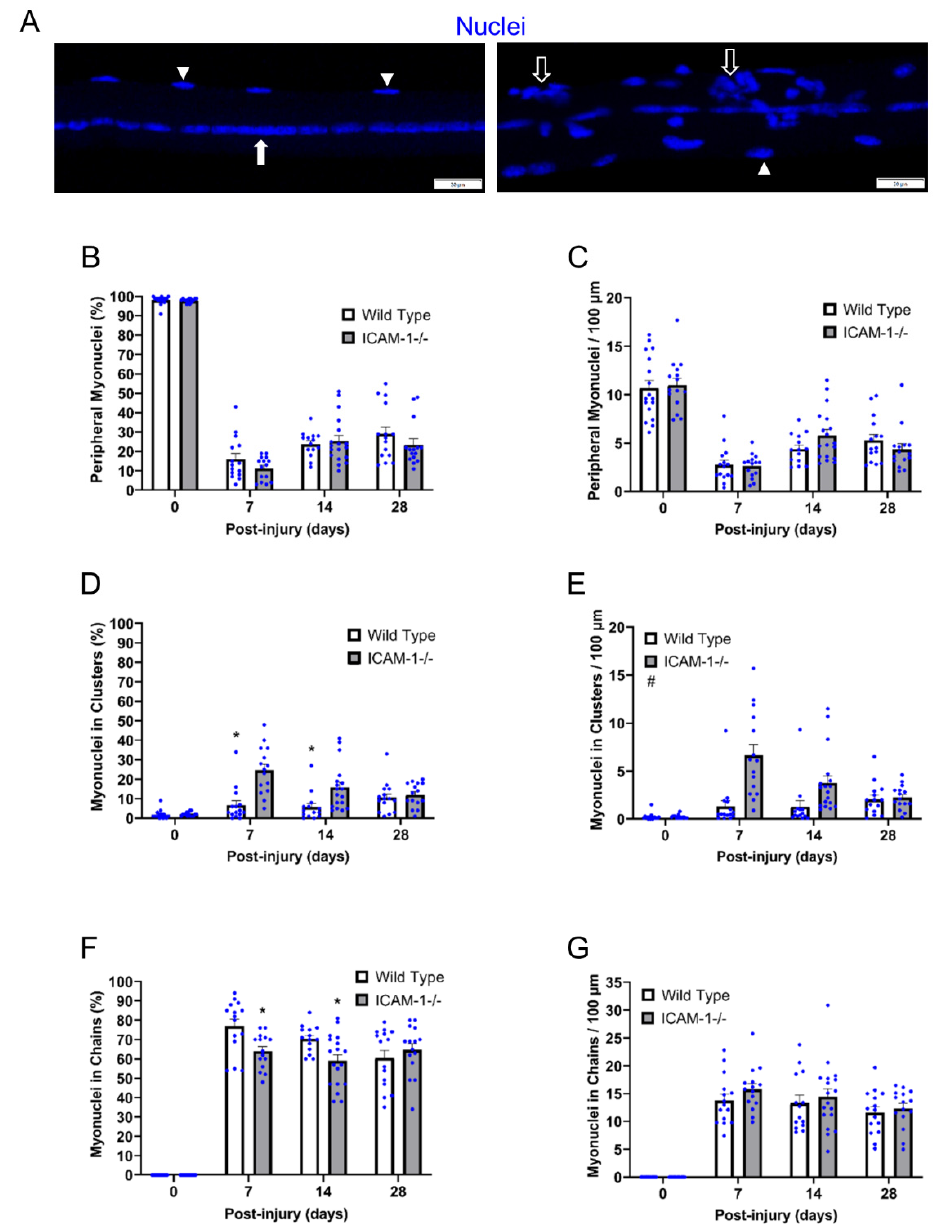
Figure 2. Myonuclear positioning before and during injury-induced muscle regeneration. ( A ) z-projection images of myonuclei (blue) positioned in chains (filled arrow), clusters (open arrow), and a peripheral position (arrowhead) during regeneration. Scale bar = 20 µ m. ( B ) The number of peripheral myonuclei expressed as a percentage of the total number of myonuclei within a myofiber and ( C ) relative to 100 μ m of myofiber length. ( D ) The number of myonuclei in chains expressed as a percentage of the total number of myonuclei within a myofiber and ( E ) relative to 100 μ m of myofiber length. * = lower for Wild Type compared with ICAM-1-/- mice at indicated time point (interaction effect; p = 0.014. ( F ) The number of myonuclei in clusters expressed as a percentage of the total number of myonuclei within a myofiber and ( G ) relative to 100 μ m of myofiber length. * = lower for wild type compared with ICAM-1-/- mice at indicated time point (interaction effect; p ≤ 0.001. # = lower for Wild Type compared with ICAM-1-/- mice (main effect; p ≤ 0.001. n = 14–18 myofibers/time point for each genotype.